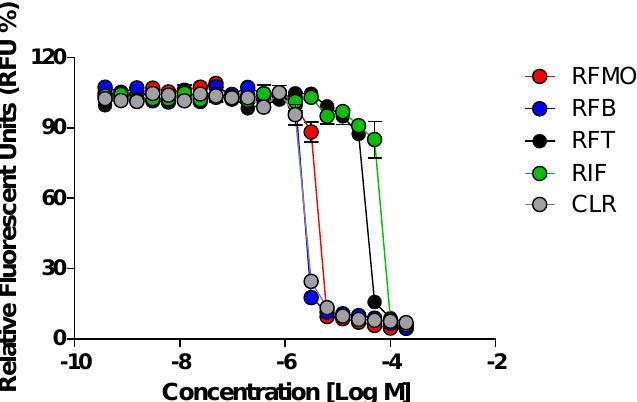
Figure 3. In vitro activity of rifamycin O. The activity of rifamycin O (RFM O) against M. abscessus CIP 104536 T R morphotype in comparison with rifabutin (RFB), rifampicin (RIF), rifapentine (RFT) and clarithromycin (CLR) in 7H9 G/T/ADC . Fluorometric minimum inhibitory concentrations (MICs) were determined by fitting the RFU% sigmoidal dose–response curves. Graph fitting is representative of three independent assays, performed in triplicate.